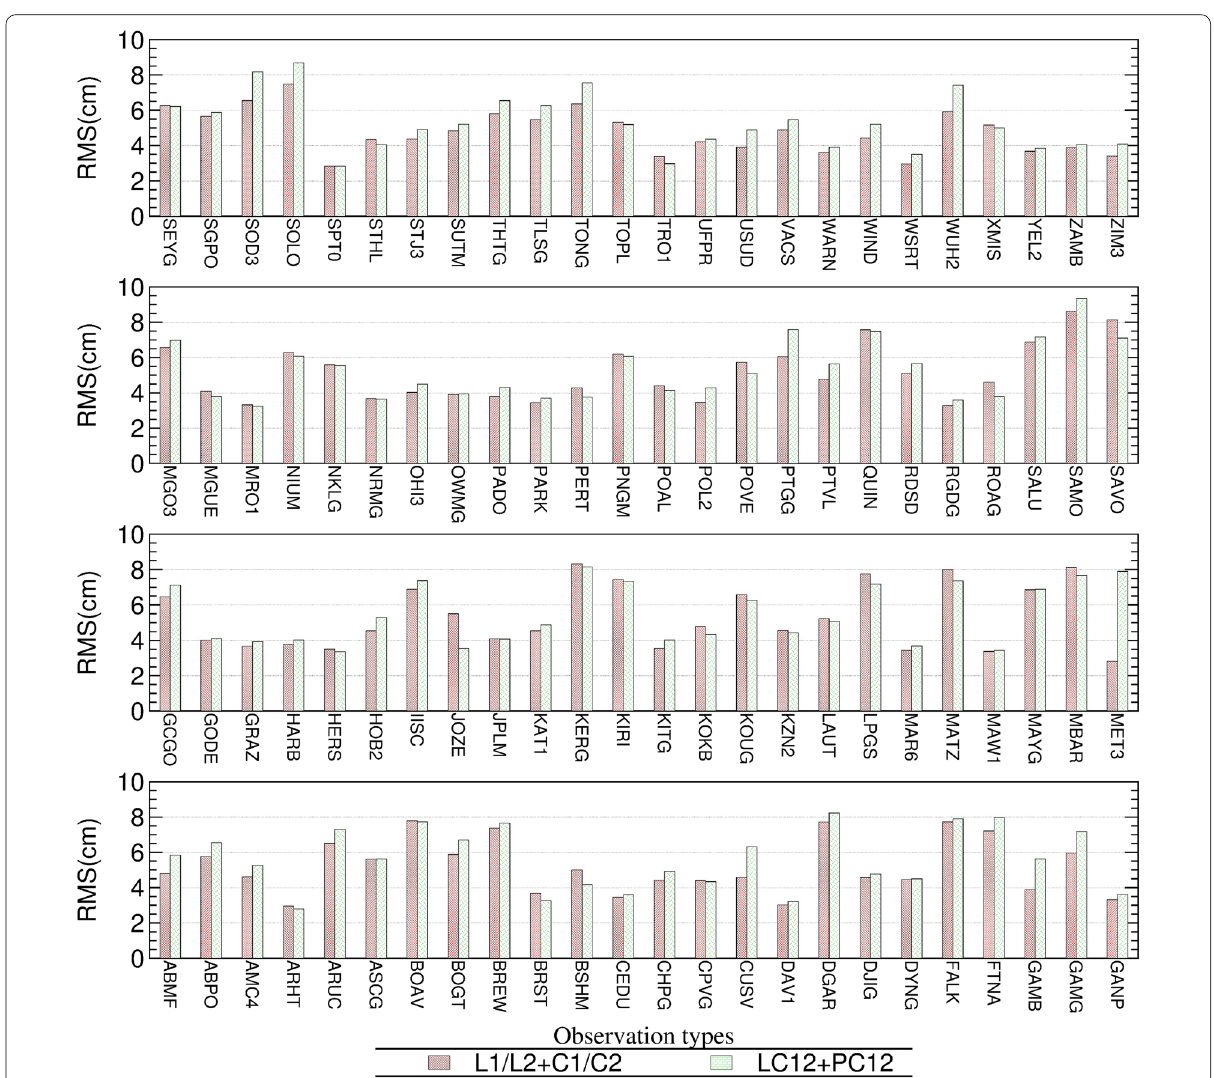
Fig. 7 3-D RMS of the GLONASS PPP results after convergence for the 96 stations during GPS week 2057